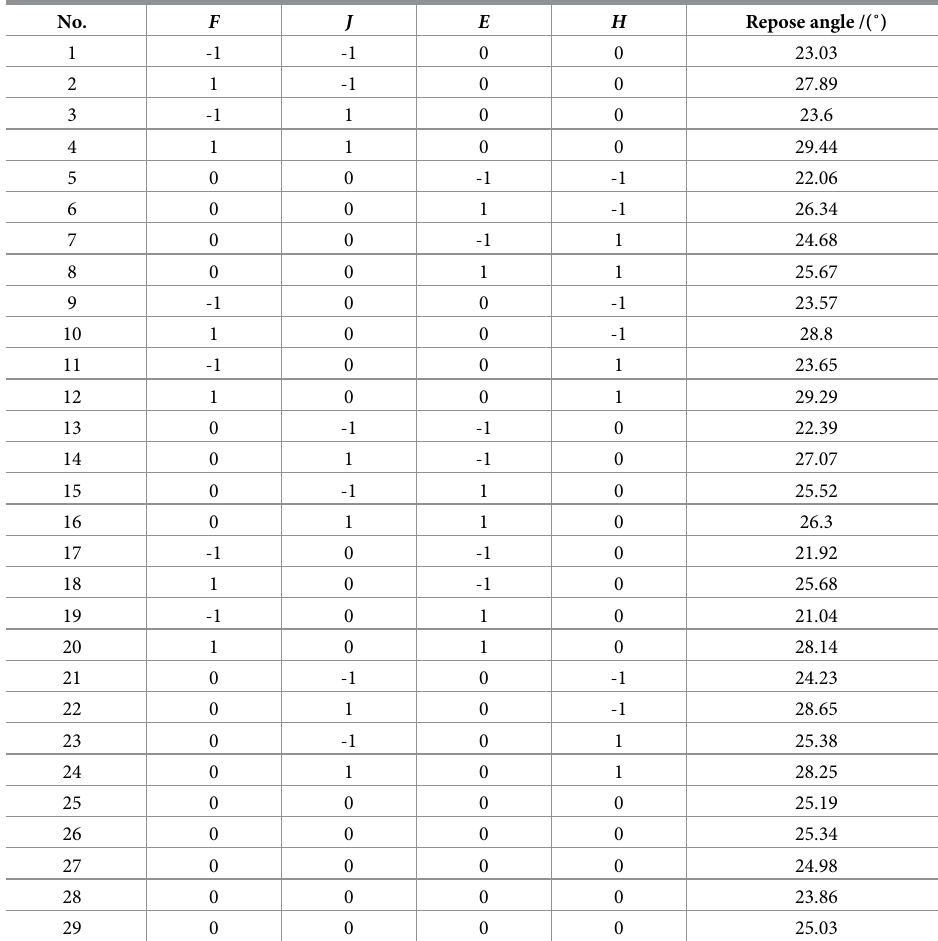
Table 6. Test scheme and